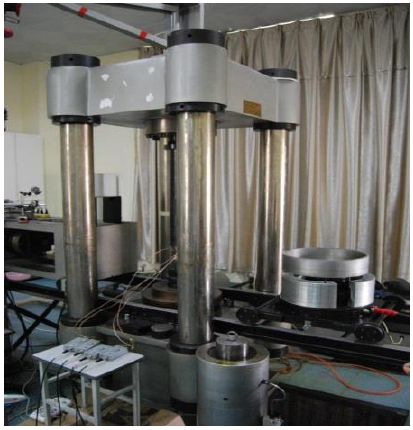
Figure 3. RLJW-2000-type test system.